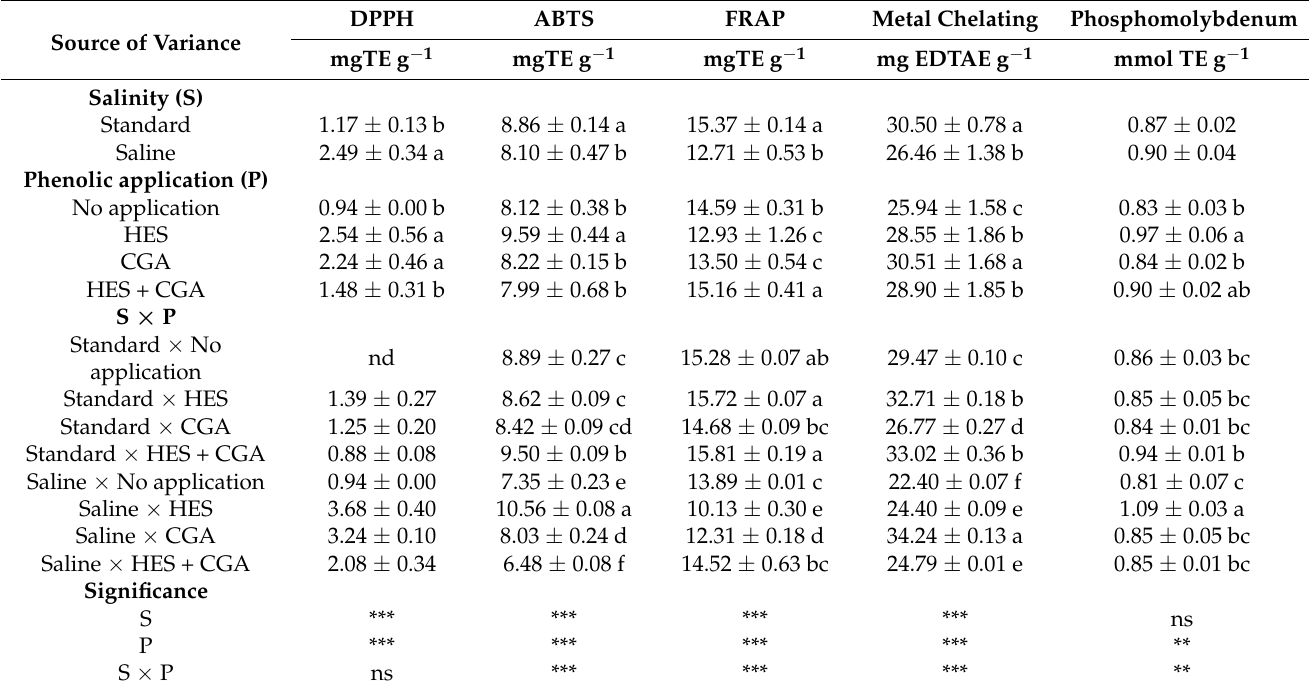
S × P Data are mean ± standard error; n = 3. The symbols ns, *, **, *** indicate nonsignificant or significant at p < 0.05, 0.01, and 0.001, respectively. Different letters within each column indicate significant differences according to Duncan’s multiple range test ( p < 0.05). The Salinity factor was compared with the independent Student’s t -test. “nd” denotes non-detectable